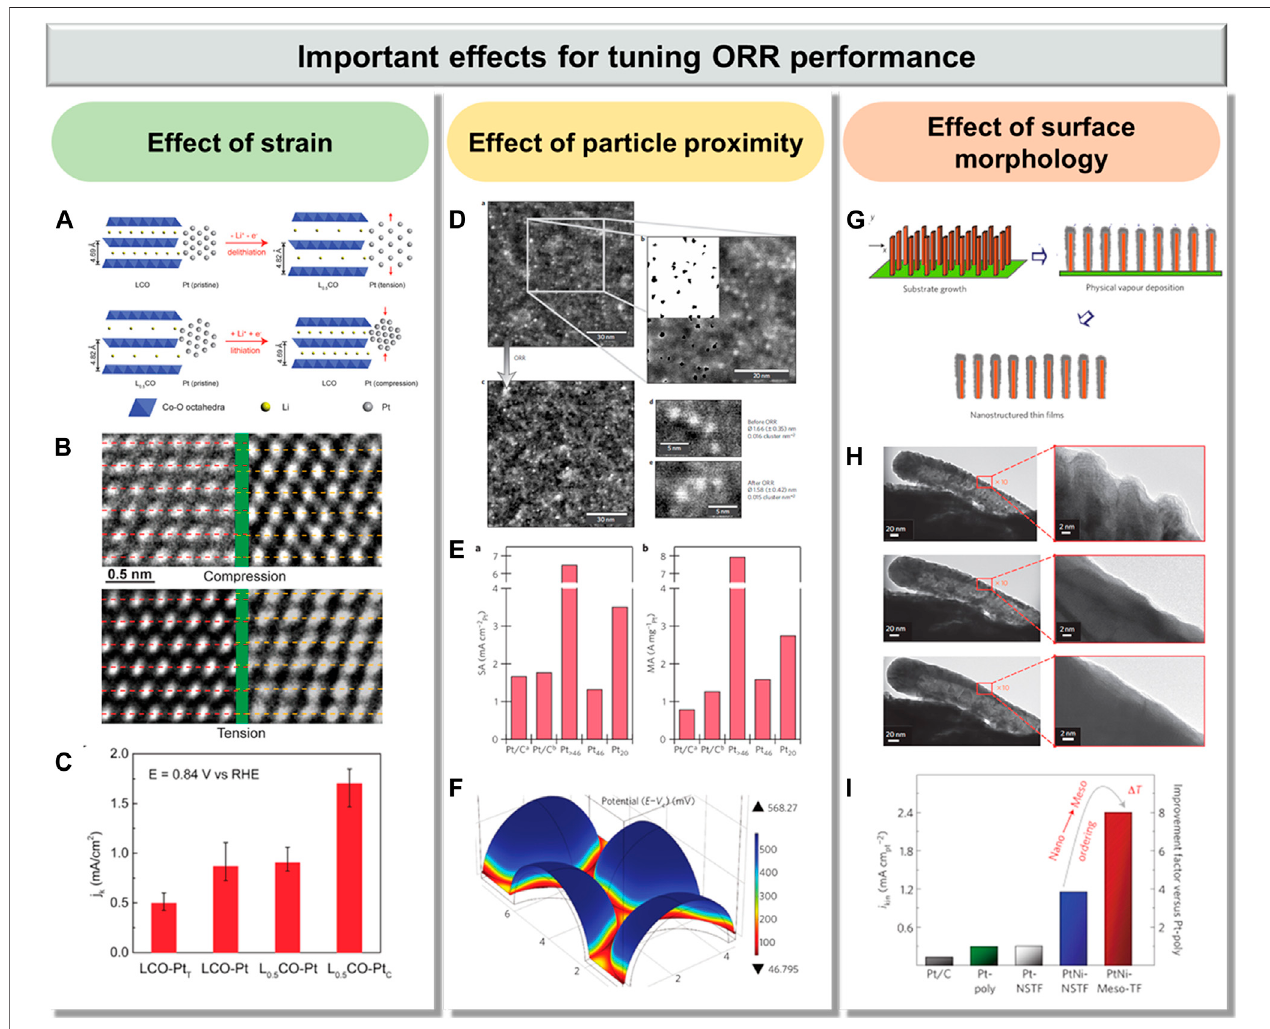
FIGURE2| EmergingeffectsinPt-basedelectrocatalystsfortuningORRperformance: (A – C) effectofstrain,reproducedwithpermissionfromref.59; (D – F) effect of particle proximity, reproduced with permission from ref. 61, respectively; and (G – I) effect of surface morphology, reproduced with permission from ref. 67.